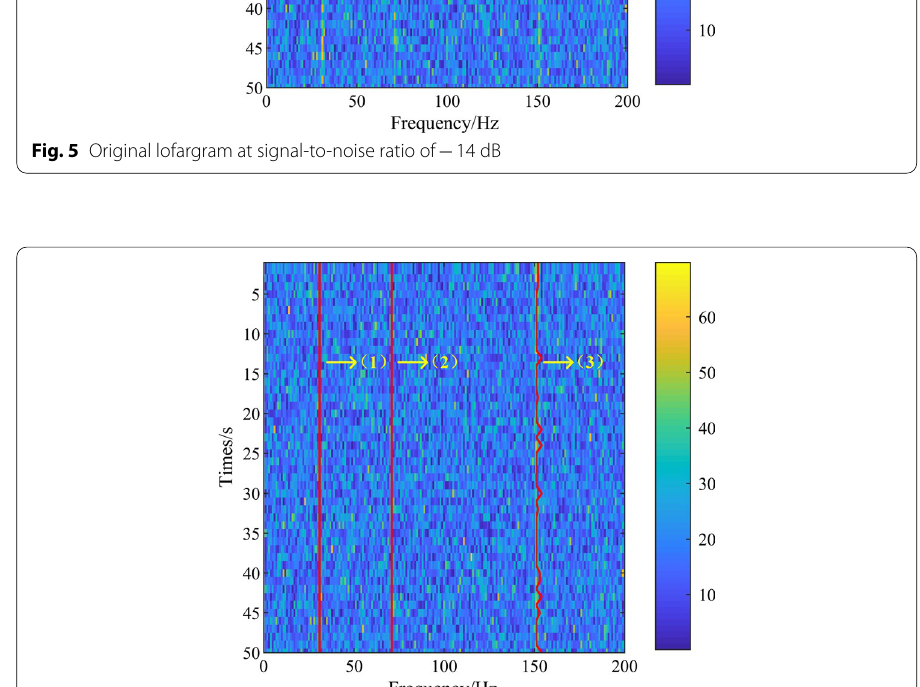
Fig. 6 Line-spectrum-extraction results of proposed algorithm at